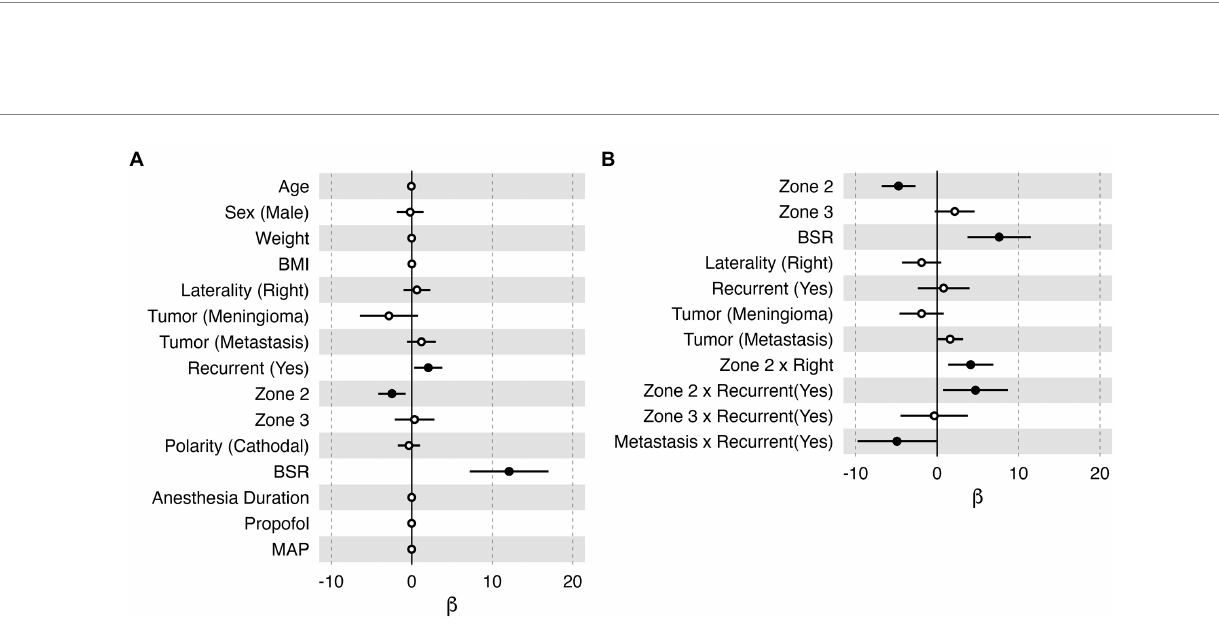
FIGURE 5 Bar plots of the effect ( β ) of each variable on the normalized stimulation current threshold in the multiple linear regression model. Each horizontal bar shows the 95% confidence interval of the effect of each variable. An effect with p < 0.05 was considered significant, illustrated with a filled black dot marking the mean value. (A) All the collected variables were included in this model. (B) The optimal model selected by the stepwise algorithm. Sex (female), laterality (left), tumor (glioma), recurrent (no), Zone 1, and polarity (anodal) were selected as references in this model; therefore, they do not have an estimation of β in these plots. BMI, body mass index; BSR, burst suppression ratio; MAP, mean arterial